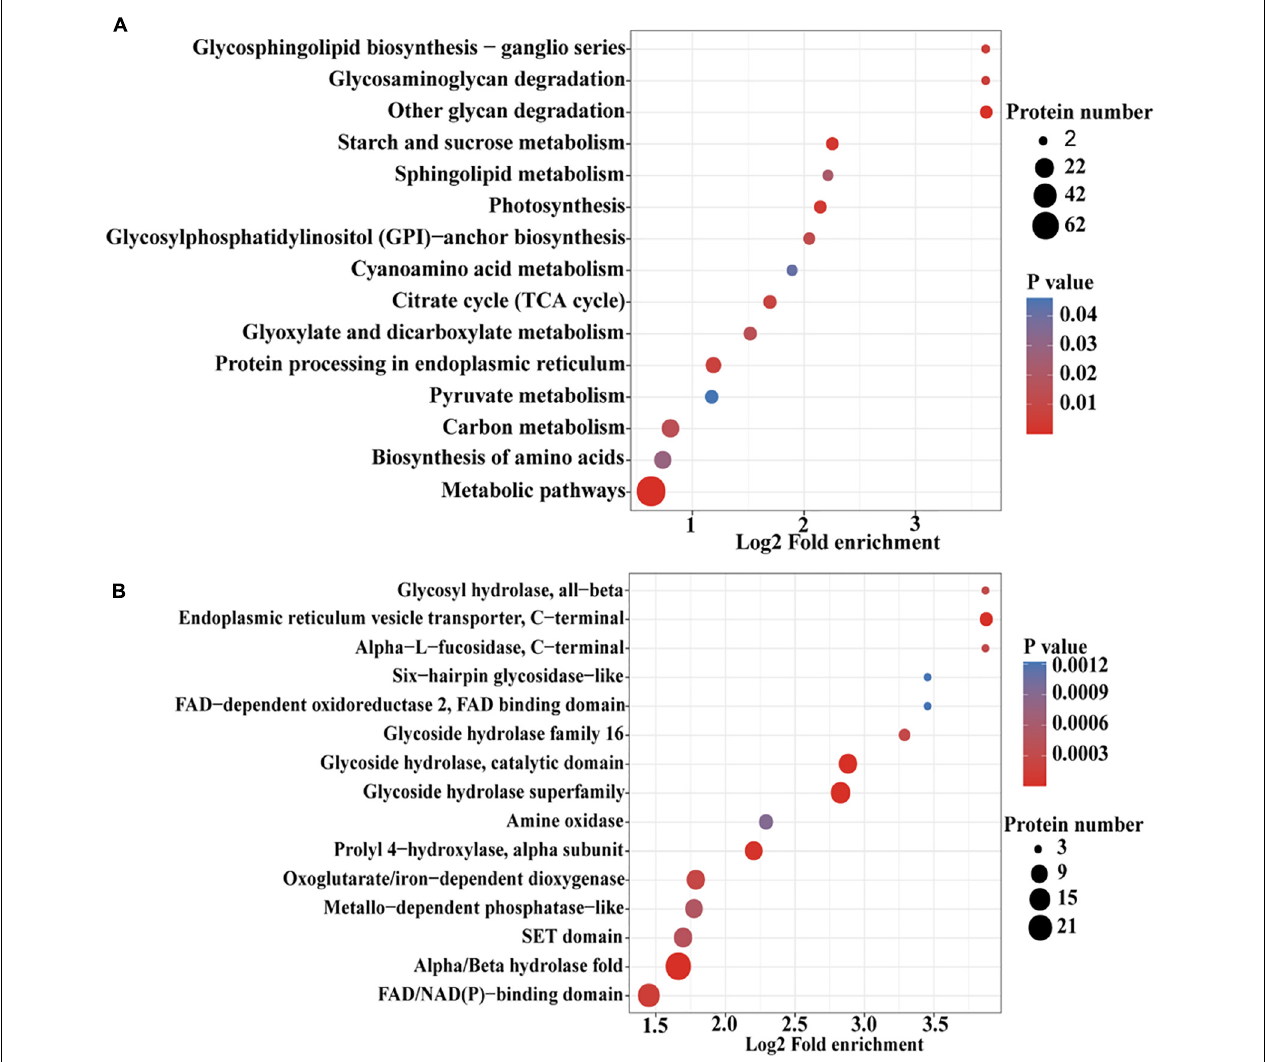
FIGURE 5 | An enrichment analysis of the N-glycoproteins based on the Kyoto Encyclopedia of Genes and Genomes (KEGG) pathways and protein domains in P. tricornutum. (A) Enrichment of N-glycoproteins based on KEGG pathways. (B) Enrichment of N-glycoproteins based on protein domains.